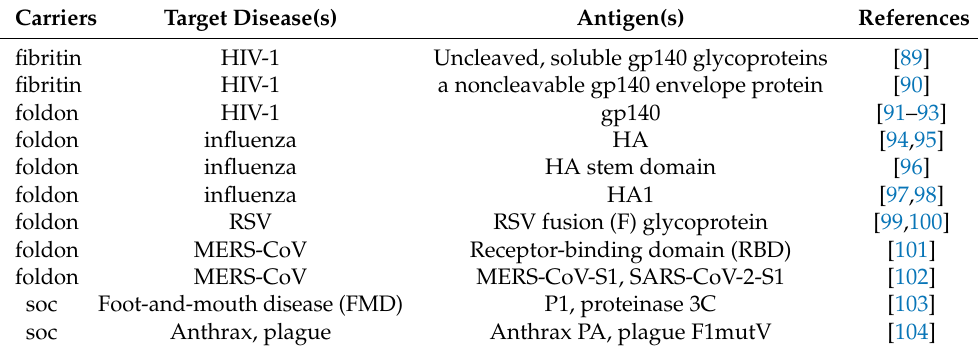
Table 1. Bacteriophage T4 building blocks as carriers for vaccines against infectious diseases. Carriers Target